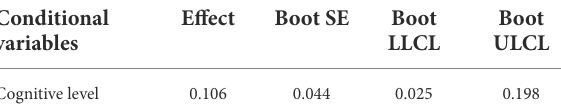
TABLE 2 Indirect effects of educational attainment on explicit attitudes through cognitive